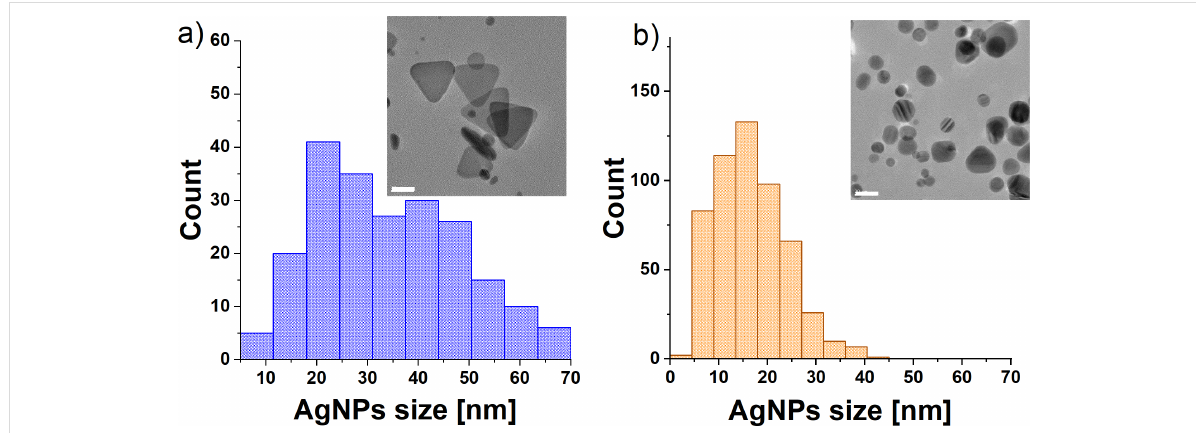
Figure 1: Size distributions and representative TEM images of AgNPs samples (white scale bar is 20 nm): (a) AgNPs blue and (b) AgNPs yellow. Ex- perimental data from [35].